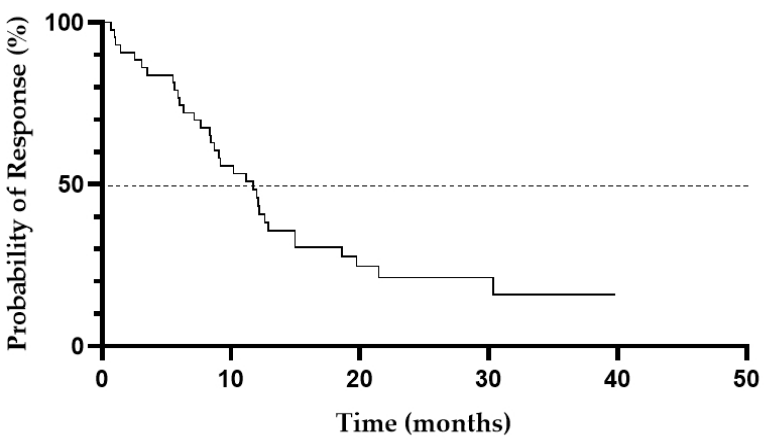
Figure 1. Duration of response in patients who achieved CR/CRi to LD-AC+cladribine. Both higher burden of comorbidities (defined as HCT-CI score ≥ 3) and adverse cytogenetic risk negatively affected the CR/CRi rate in the univariate analysis (CR/CRi rate 47.9% and 28.4%, respectively, for patients with HCT-CI score of 0–2 vs. ≥ 3, p = 0.03; CR/CRi rate 19.6% and 51%, respectively, for patients with adverse vs. intermediate cytogenetic risk, p = 0.009) (Table 2). However, in the multivariate analysis only adverse cytogenetic risk negatively affected the CR/CRi rate (Table 2). Table 2. Univariate and multivariate analyses of factors affecting the CR/CRi rate. Independent Variable